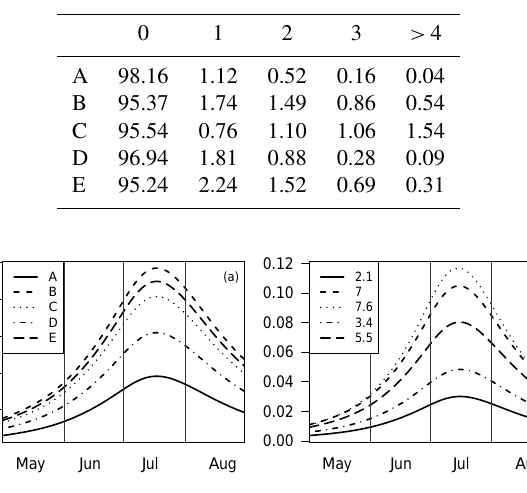
Figure 8. Seasonal climatologies for sample locations, which are highlighted in Fig. 1. (a) Occurrence model. (b) Expected number of flashes. The legend shows expected number of flashes accumu- lated over the lightning season.